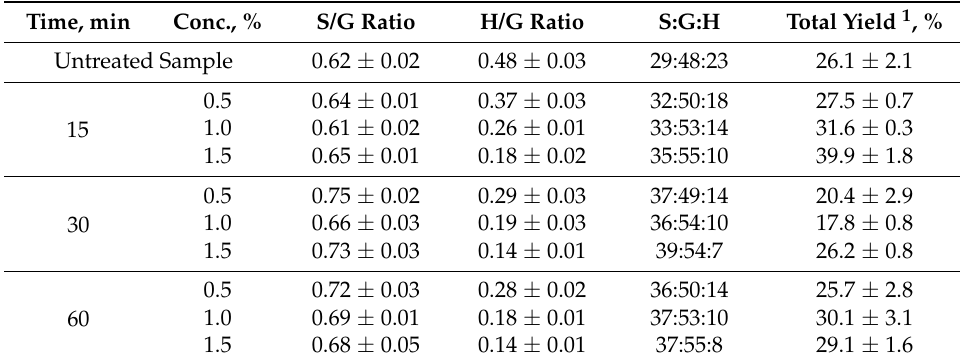
Table 3. Changes in the ratio of S/guaiacyl (G), p -phydroxyphenyl (H)/G, and S:G:H after NaOH pretreatment of switchgrass and total yield (%) by nitrobenzene